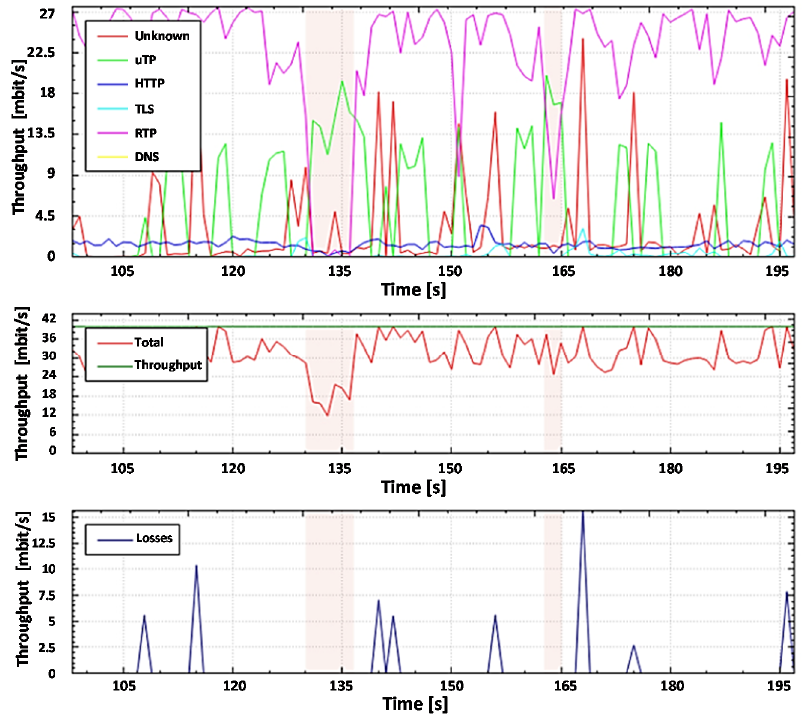
Figure 25. Values in 60 seconds with 3-second monitoring window for "anomaly" class (Non-Spoofed UDP Floods attack).